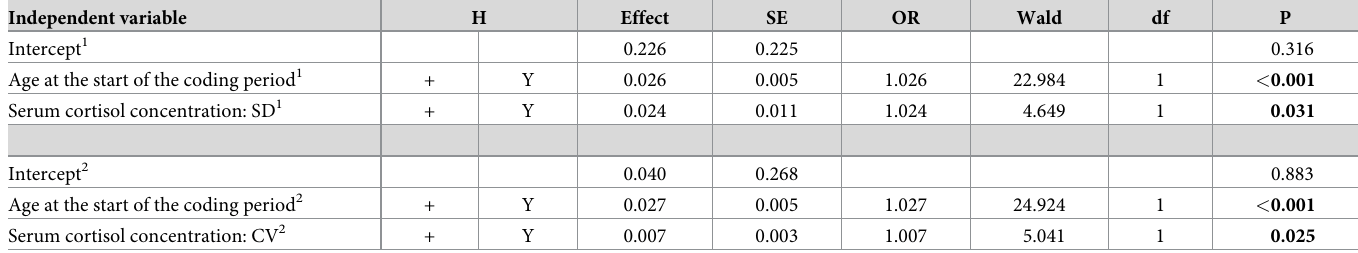
Table 8. Multivariate assessments of the total number of clinical events with the standard deviation 1 and the coefficient of variation 2 in serum cortisol by Poisson regression. Hypotheses (H): positive (+) or negative (-) relationship of each variable with the number of clinical events per animal as a measure of elephant welfare, and whether observed relationships were in the predicted direction (Y yes / N no).